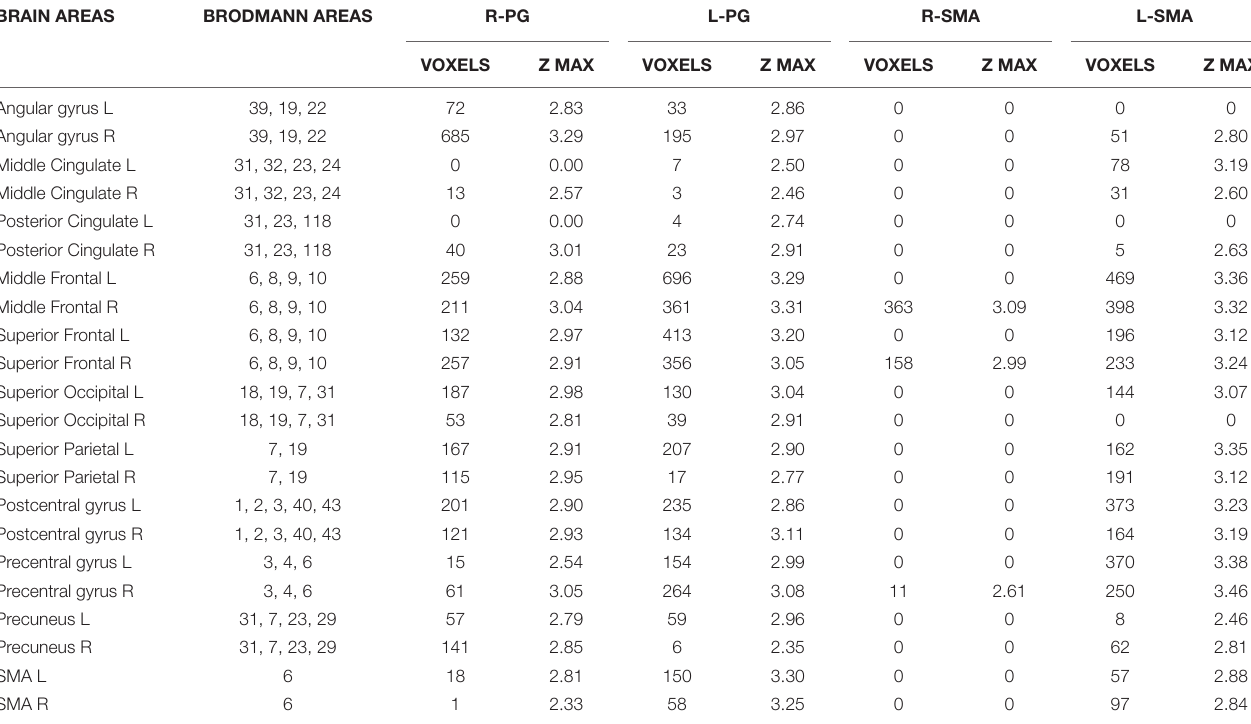
TABLE 2 | Brain areas showing a significant variation in fMRI connectivity with the four seeds (R-PG, L-PG, R-SMA, and L-SMA) when comparing the ON and the OFF state. BRAIN